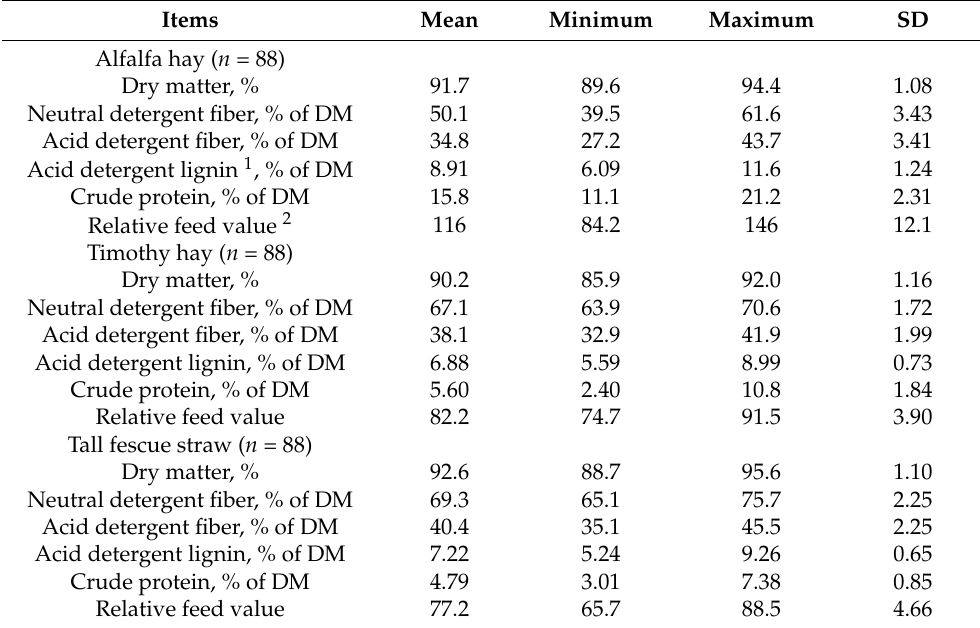
Table 3. Descriptive statistics of chemical composition and nutritive value of alfalfa hay, timothy hay, and tall fescue straw (experiment